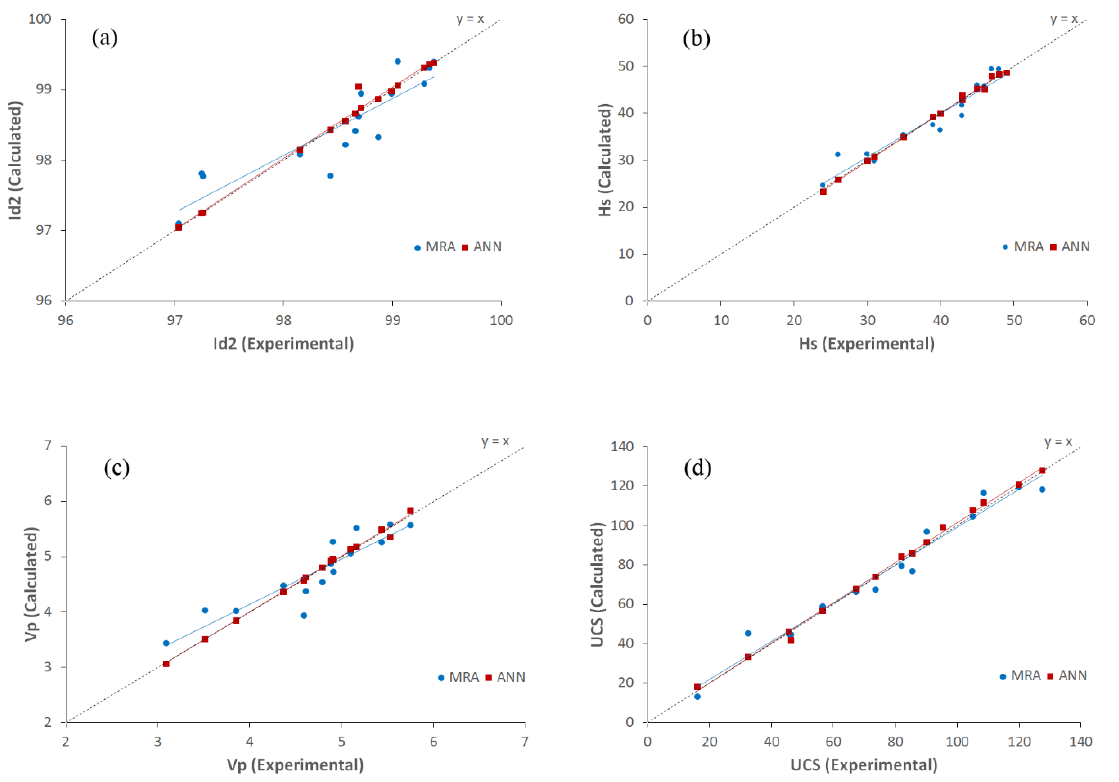
Figure 16. Plots of experimental and calculated values of ( a ) Id 2 , ( b ) SRH, ( c ) UPV, and ( d ) UCS from the MRA and ANN.